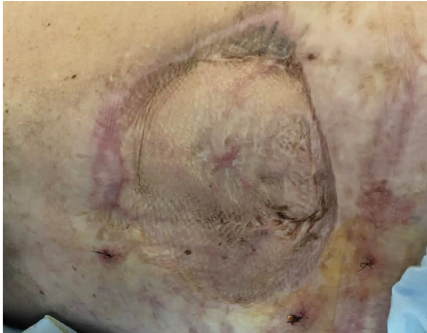
Figure 2: Dorsal region after wide surgical extirpation and re- construction with meshed split-thickness skin grafts.